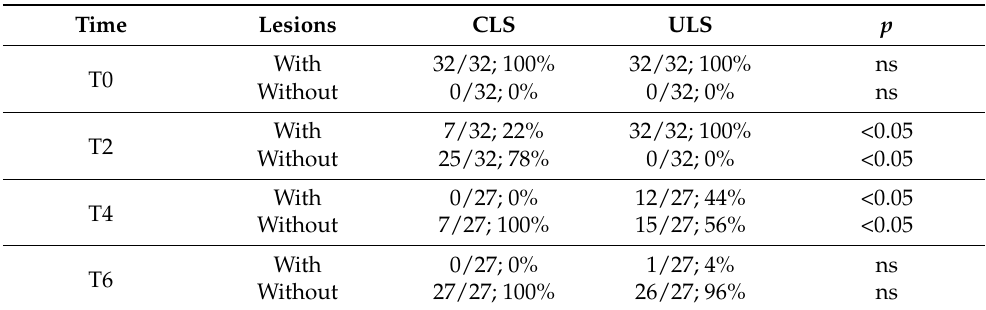
Table 3. Dogs with (score > 1) or without (score < 1) clinical lameness using the Clinical Lameness Score (CLS) and dogs with (score mild to severe) or without (score none) lesions found at ultrasound using the Ultrasound Lesion Score (ULS) at their first visit (T0) and at two months (T2), four months (T4) and six months (T6) after T0.